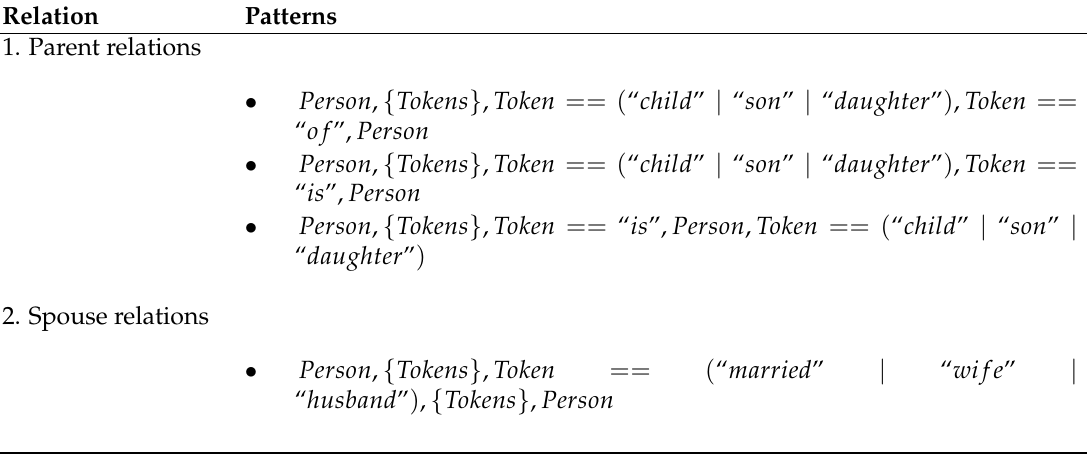
Table 1. JAPE grammar